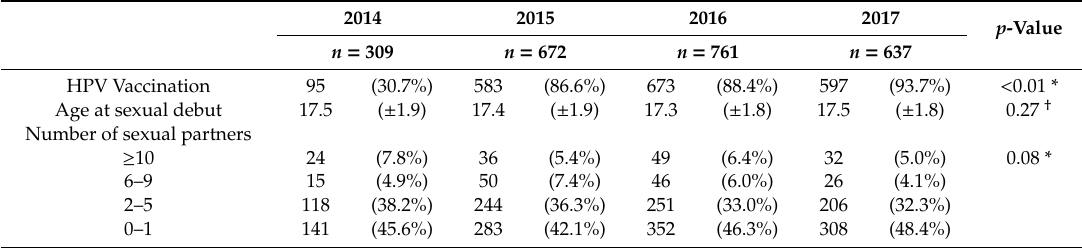
Table 2. Characteristics of participants.